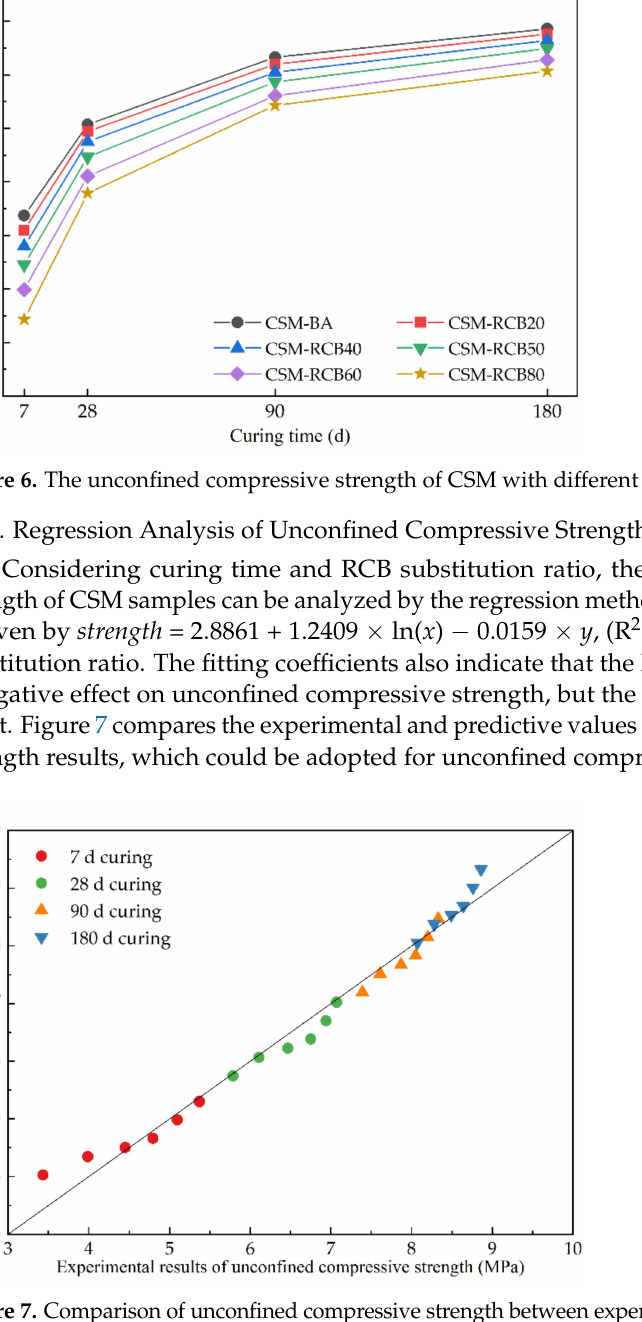
Figure 7. Comparison of unconfined compressive strength between experimental and predictive